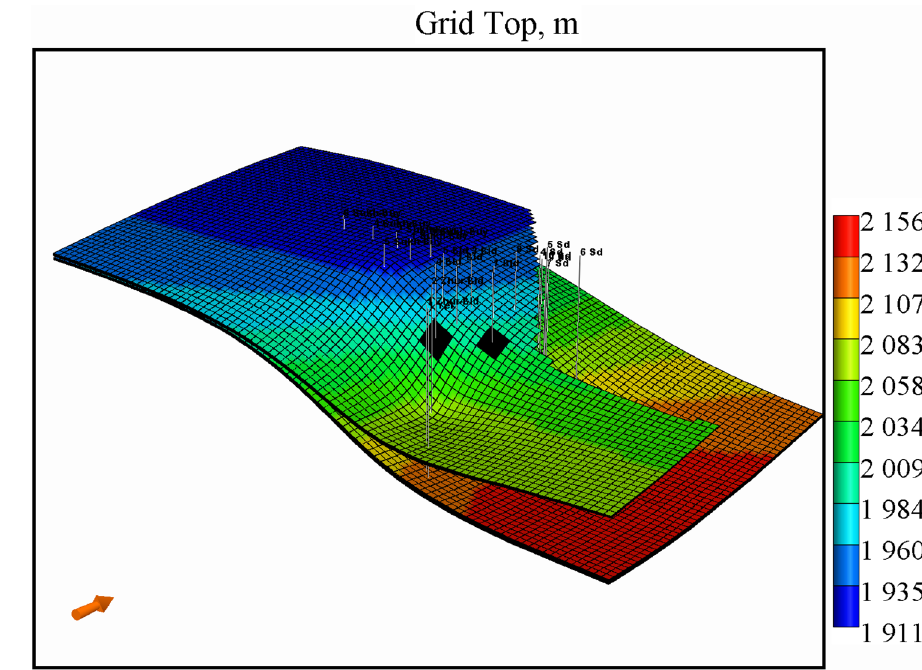
Fig. 10 General view of the reservoir model of Paleocene Layers I and II